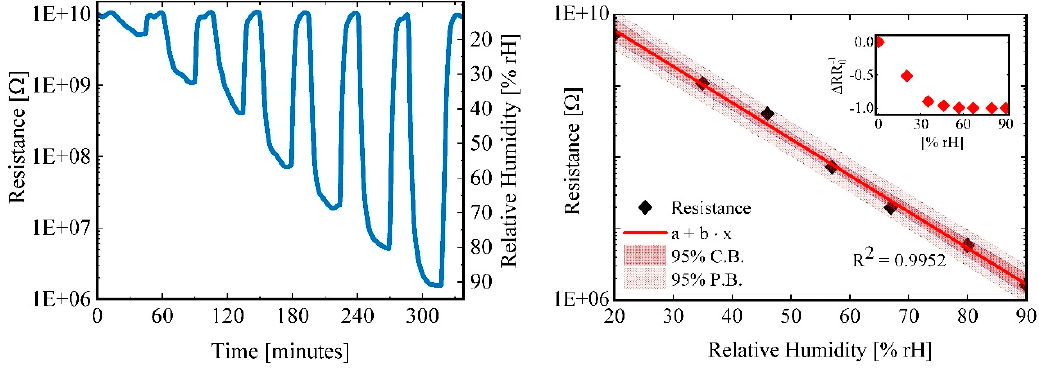
Figure 2. ( a ) Sensor response under different humidity pulses; ( b ) relative humidity-electrical resistance relationship. Y axis is logarithmic while the inset plot presents the percentage change of resistance for different humidity values.